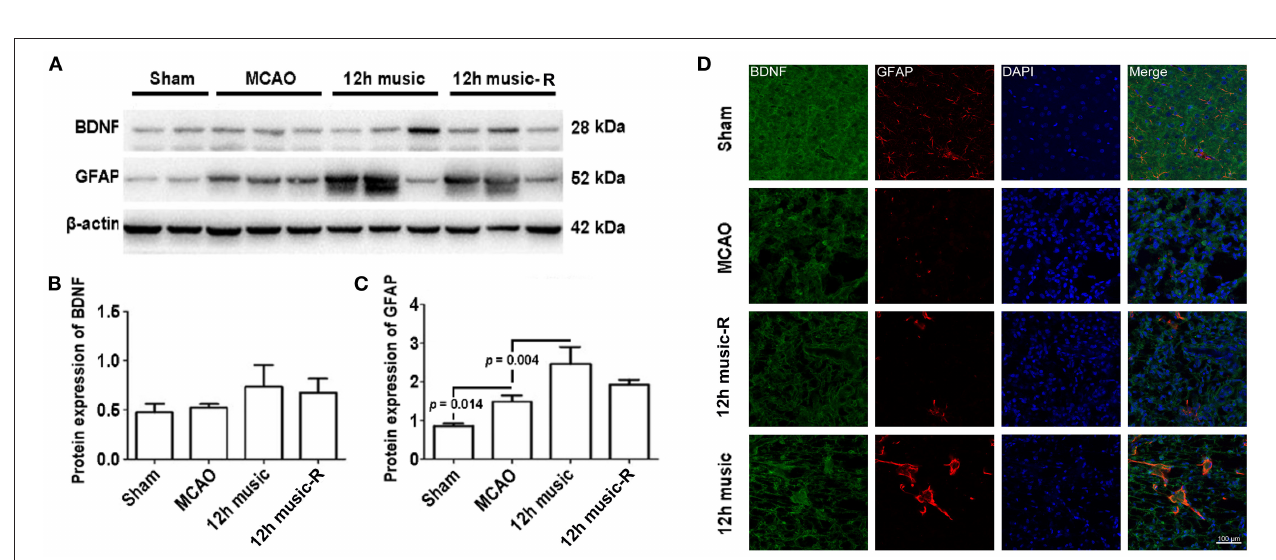
FIGURE 6 | Effects of 12h music therapy on BDNF and GFAP expressions at 4 weeks after MCAO. (A) Western blot analysis of BDNF in the lesioned area. Quantification of (B) BDNF and (C) GFAP examined by Western blot. (D) Relative fluorescence intensity of BDNF and GFAP in motor cortex. The BDNF and GFAP expressions were examined after 3 weeks of intervention in the 12-h music group and after 2 weeks of intervention plus 1-week rest in the 12-h music-R group.